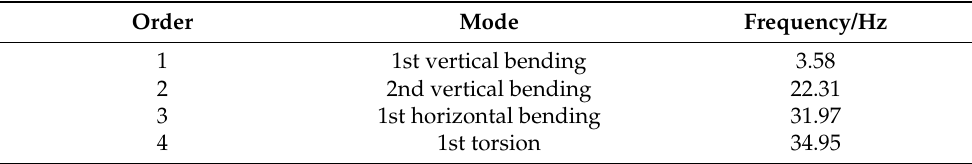
Table 3. Wing component mode analysis results.